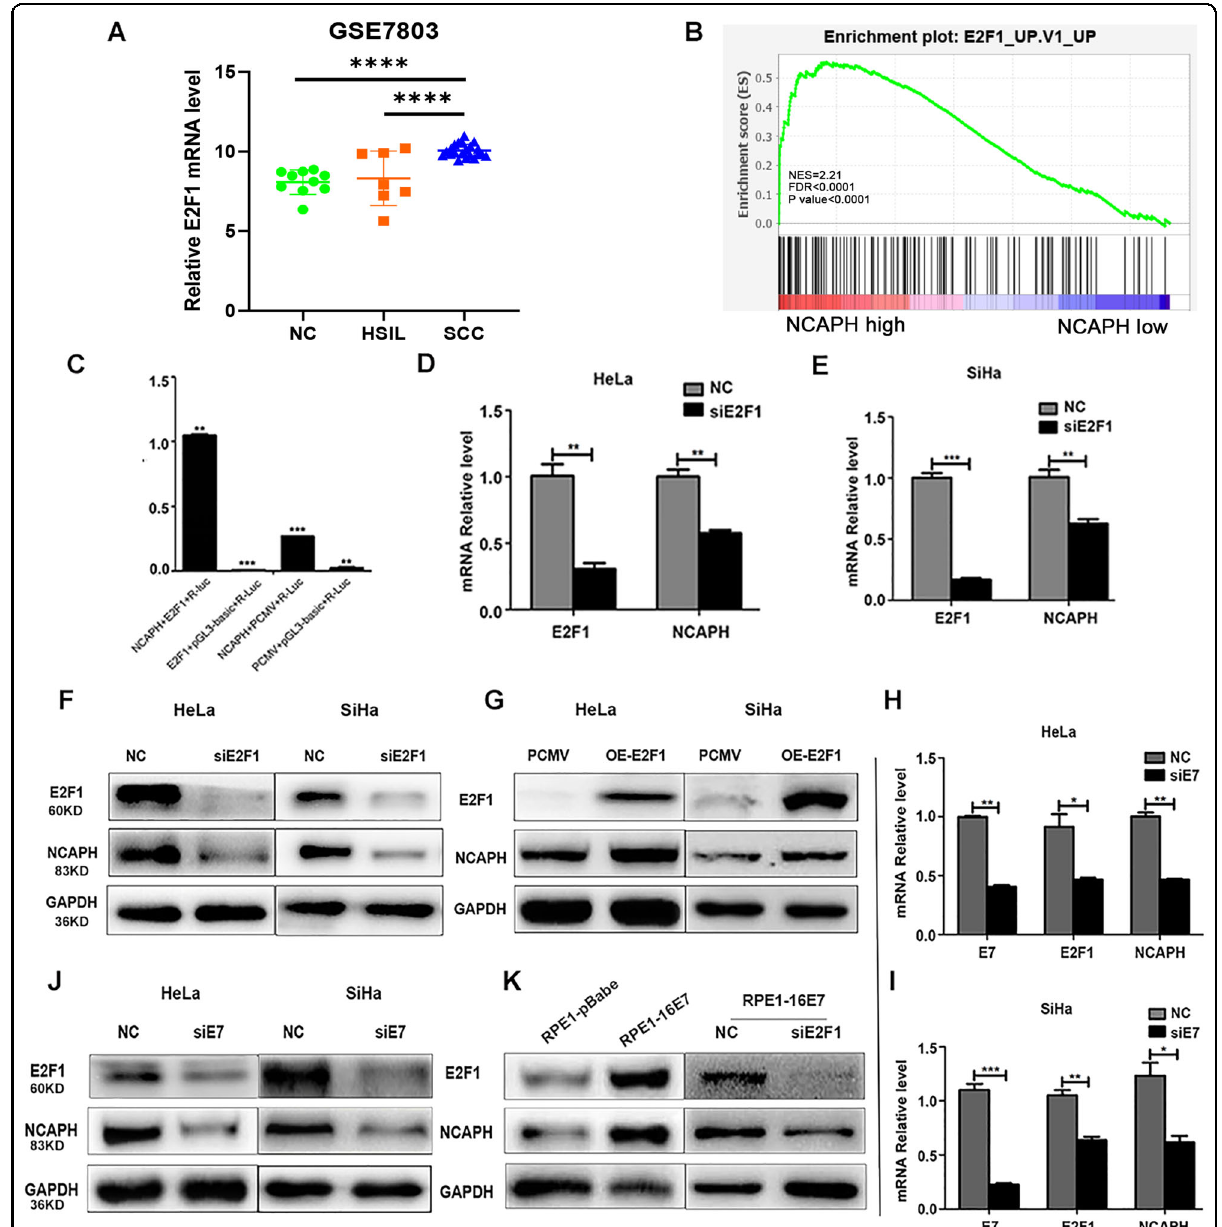
Fig. 5 HPV E7 upregulates the gene expression of NCAPH through transcription factor E2F1. A The expression of E2F1 in normal cervix (NC) ( n = 10), HSIL ( n = 7) and squamous cell carcinoma (SCC) ( n = 21) based on the data from GEO database (GSE7803). B GSEA analysis based on GSE7803 revealed the enrichment of E2F1 with high NCAPH expression. C The luciferase assay showed that the luciferase activity increased dramatically when E2F1 overexpression plasmid (pCMV-E2F1) was co-transfected with 3 ’ -UTR regions of NCAPH gene (pGL3-NCAPH) into 293T cells. E2F1, pCMV-E2F1; NCAPH, pGL3-NCAPH; pGL3-Basic, mock vector; pCMV, mock vector. D , E , F Real-time PCR and Western Blot analysis showed that mRNA and protein levels of NCAPH decreased with the knock-down of E2F1 in HeLa and SiHa cells. NC, cells treated with negative control siRNA; siE2F1, cells treated with siRNA targeting E2F1 gene. G Overexpression of E2F1 signi fi cantly increased the protein level of NCAPH in HeLa and SiHa cells. pCMV, cells transfected with pCMV mock vector; OE-E2F1, cells transfected with pCMV-E2F1 plasmid. H , I , J Real-time PCR and Western Blot analysis showed that E2F1 and NCAPH expression decreased with the knock-down of E7 in HeLa and SiHa cells. NC, cells treated with negative control siRNA; siE7, cells treated with siRNA targeting E7 gene. K Western Blot analysis showed that the over-expression of E7 in RPE1-16E7 cells increased the expression of E2F1 and NCAPH signi fi cantly. With the interference of E2F1 expression, NCAPH level in RPE1-16E7 cells decreased dramatically. Data are presented as mean ± SD ( n = 3). * represents p < 0.05, ** represents p < 0.01, *** represents p < 0.001, **** represents p <